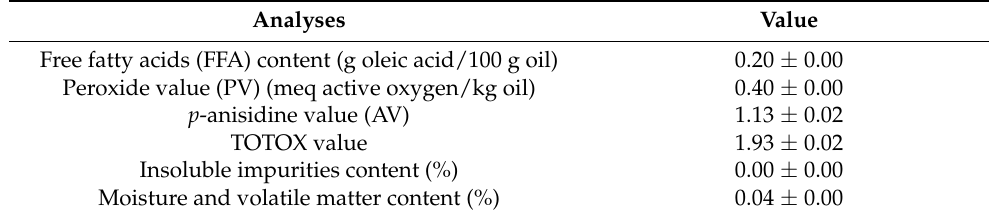
Table 1. Physical and chemical characterization of deodorized refined commercial salmon oil. Analyses Value Free fatty acids (FFA) content (g oleic acid/100 g